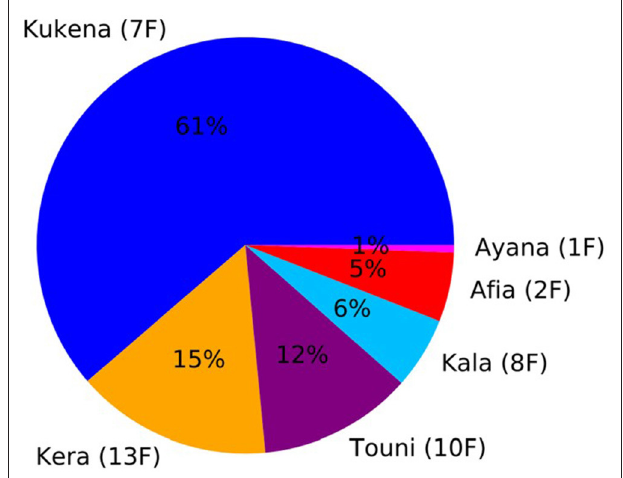
FIGURE 7 | Usage Pie Chart. The figure shows the proportion of time spent by each gorilla engaging with the Gorilla Game Lab device over a 30-min segment. The age and sex of the gorilla is indicated in brackets (i.e., 1F indicates a 1 year old female). Kukena, 7 year old female and daughter of Jock, the male silverback, engages with the device the most. Ayana, 1 year old female, engages with the device the least.